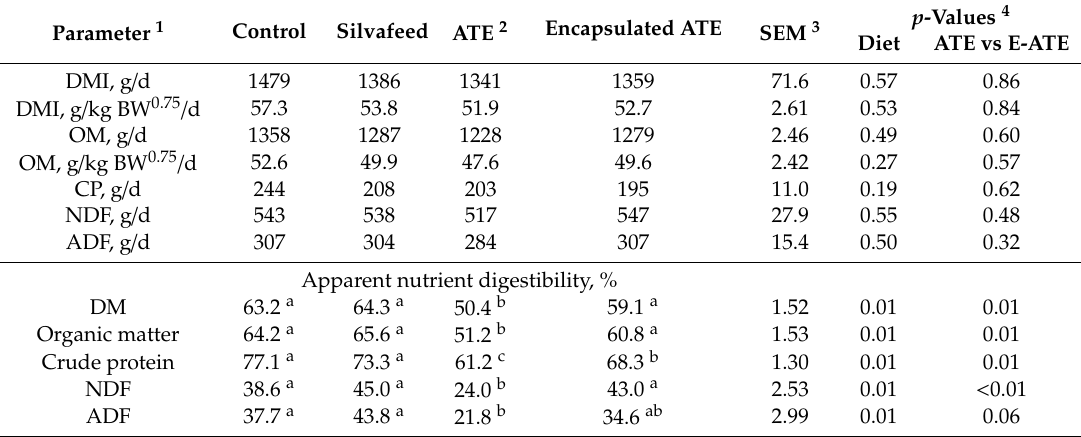
Table 2. Feed intake and apparent nutrient digestibility in Merino wethers fed total mixed ration containing crude or lipid-encapsulated Acacia tannin extract (ATE) and Silvafeed. Parameter 1 Control Silvafeed ATE